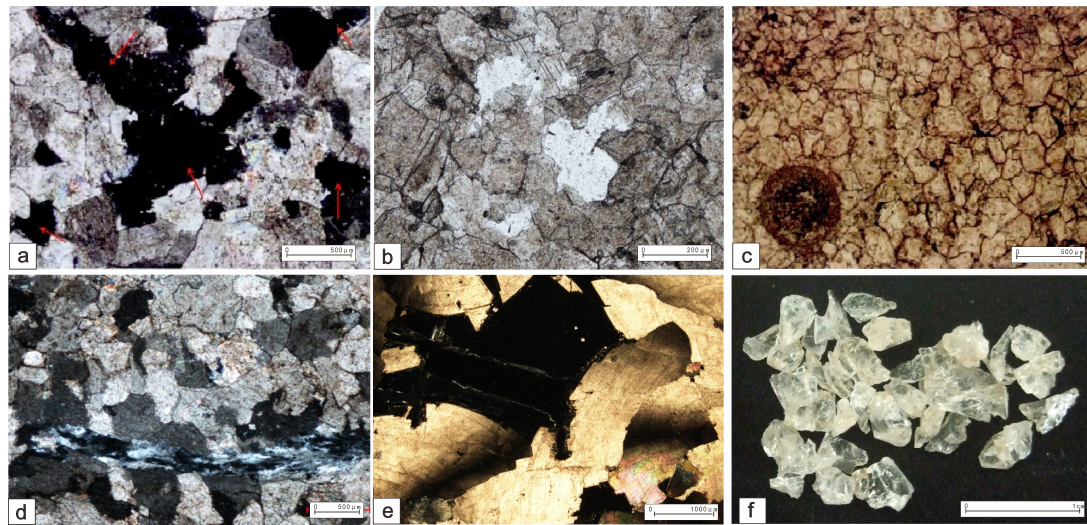
Figure 5. Thin section photos of dolomite samples from well W83. ( a ) Mesocrystalline dolomite, intercrystalline pores, intercrystalline dissolved pores, P 1 m 2 a, 3314 m, orthogonal polarization ( + ); ( b ) P 1 m 2 a, 3317 m, single polarized light (-); ( c ) Mesocrystalline dolomite, containing bioplastics, siliceous, P 1 m 2 a, 3324.5 m, single polarized light (-); ( d ) Mesocoarse dolomite, P 1 m 2 a, 3318 m, orthogonal polarized light ( + ); ( e ) Mesocrystalline dolomite, karst cave, P 1 m 2 a, 3318.5 m, orthogonally polarized light ( + ); ( f ) Columnar self-crystal quartz, P1m2a, 3328